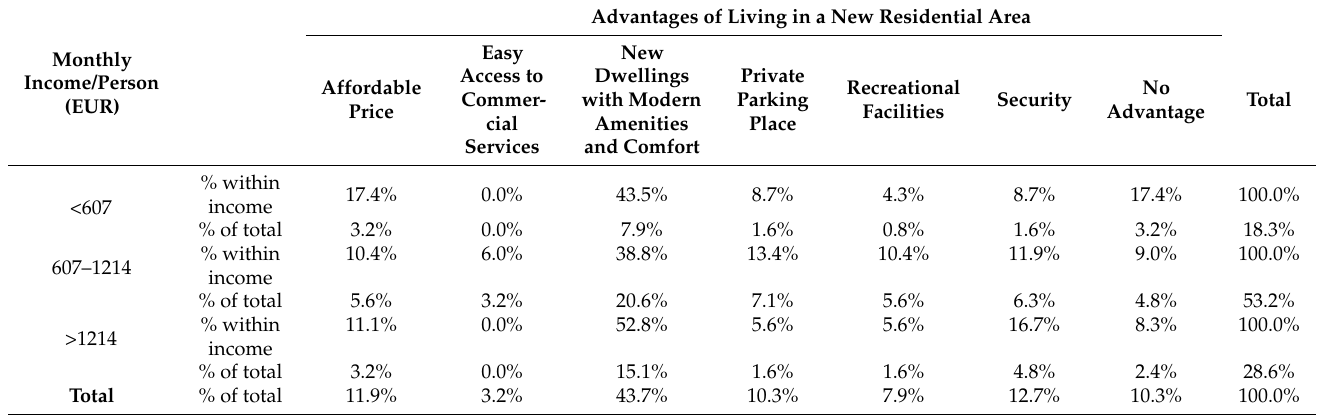
Table 2. Advantages of living in a new residential area by income brackets